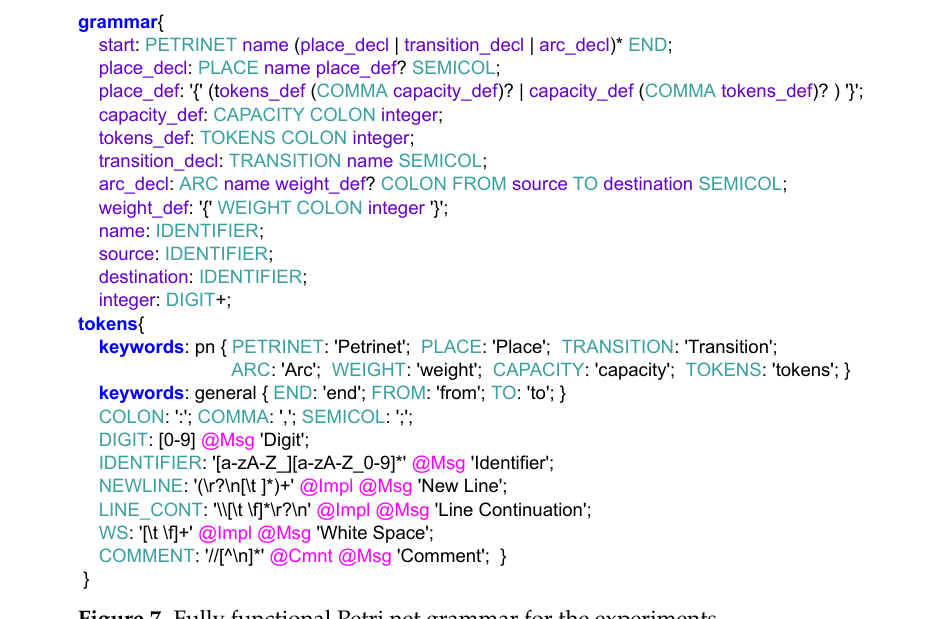
Figure 7. Fully functional Petri net grammar for the